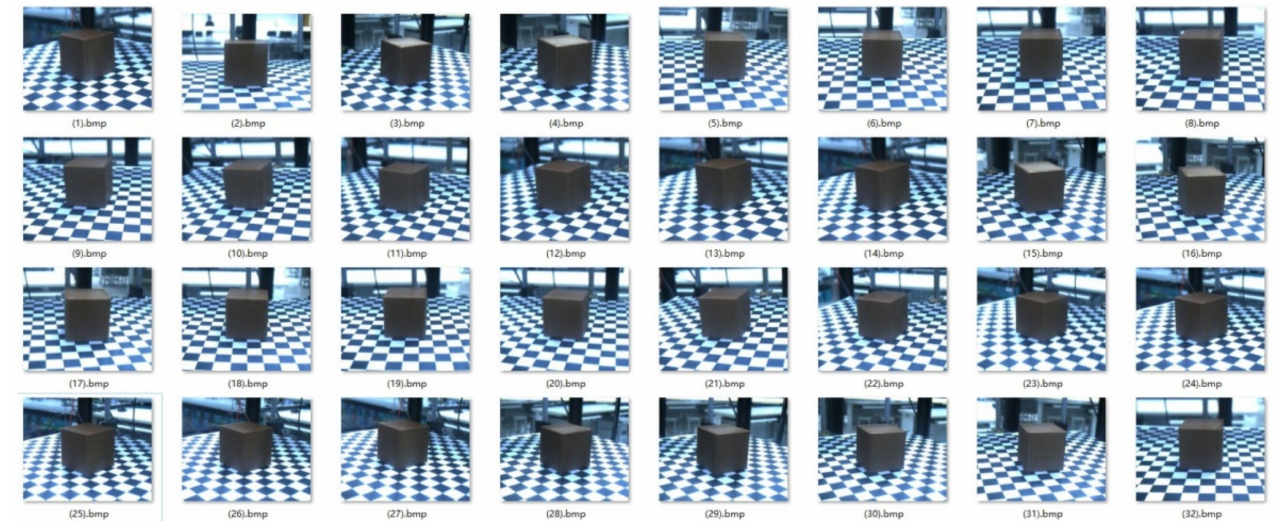
Figure 13. Part of the images collected during 3D